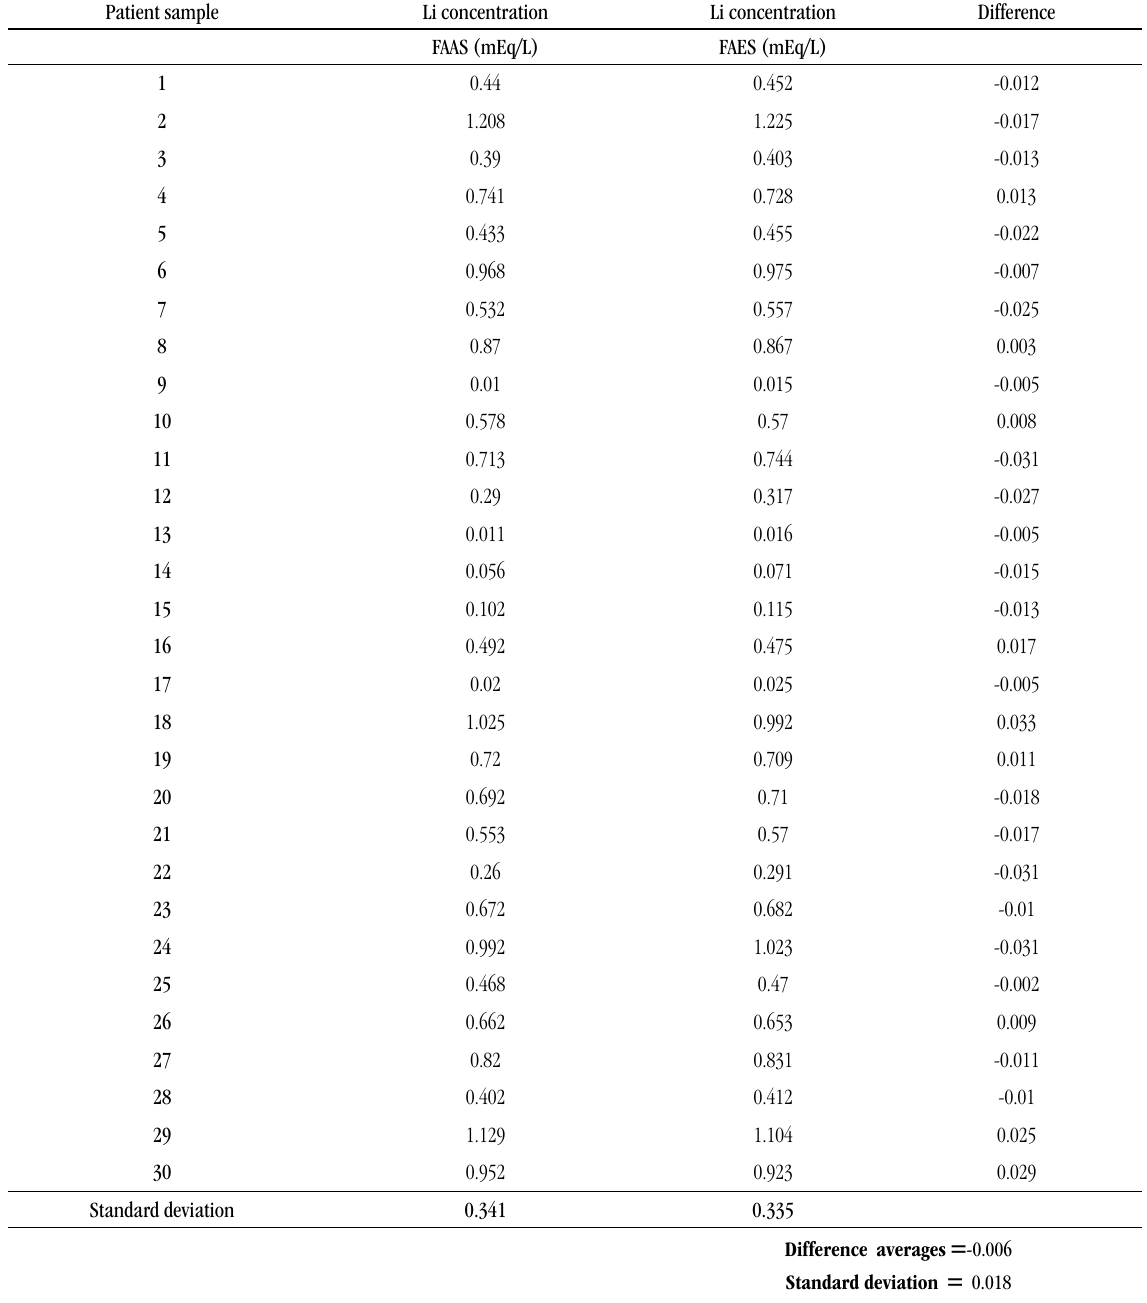
tABLE 3 – Result of lithium dosage in patients ( n = 30) treated with lithium carbonate and comparison of both methods ( t -test) Patient sample Li